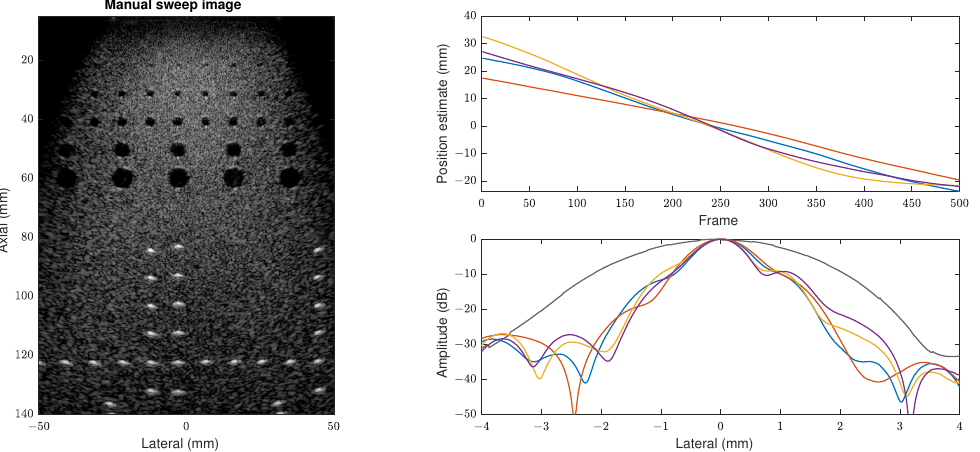
Figure 10. Results of four manual sweeps using linear slide fixture. ( Left ) Sample SSA image from one manual sweep using channel correlation estimate (50 dB dynamic range). ( Right top ) Motion estimates showing variation in sweep extent and temporal profile of manual sweeps. ( Right bottom ) Lateral PSF for manual sweeps showing consistent results with slight variations due to phantom position and sweep extent. Reference PSF from Figure 8 shown in